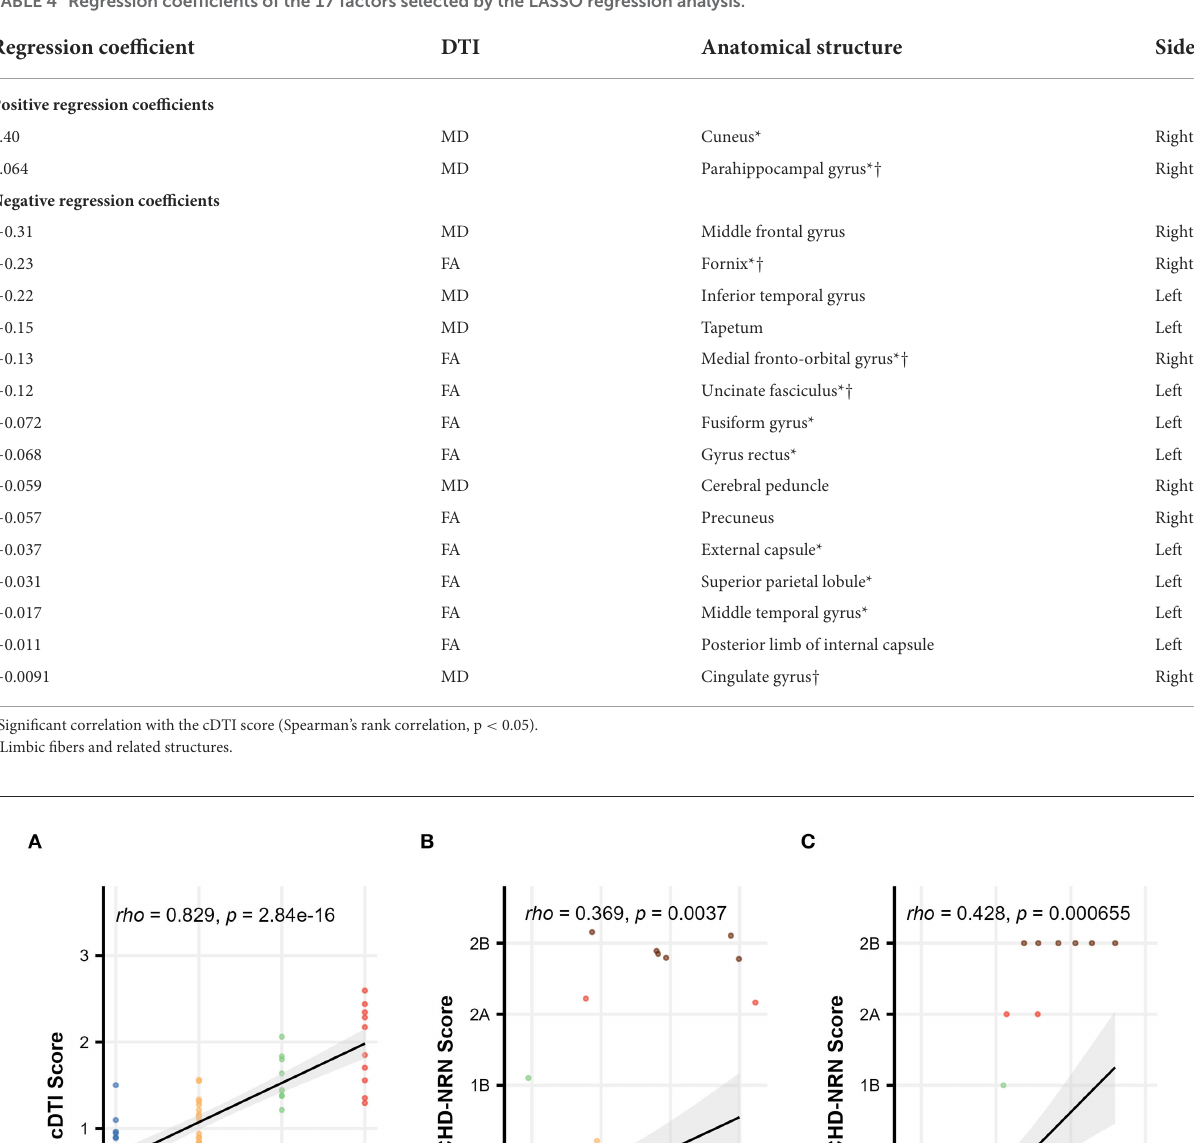
= 0.016), and IL-10 ( p = 5.9 × 10 − 10 ). Significant interactions between time point and severity were found for VEGF ( p = 0.0043) and IL-10 ( p = 1.7 × 10 − 9